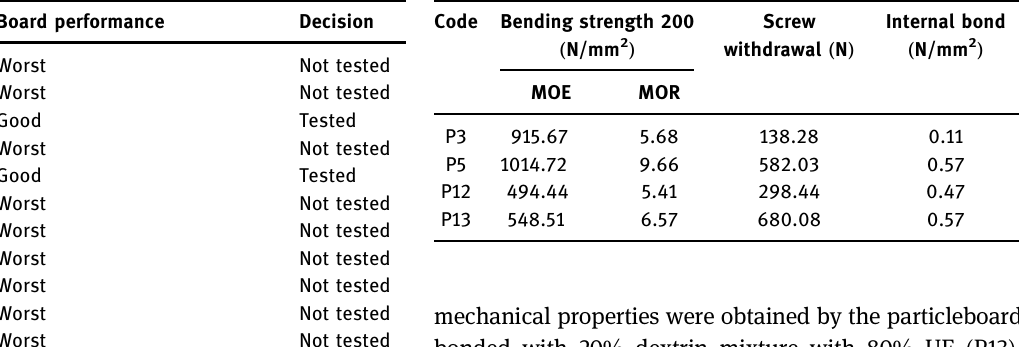
Table 2: Decision for testing particleboards Code